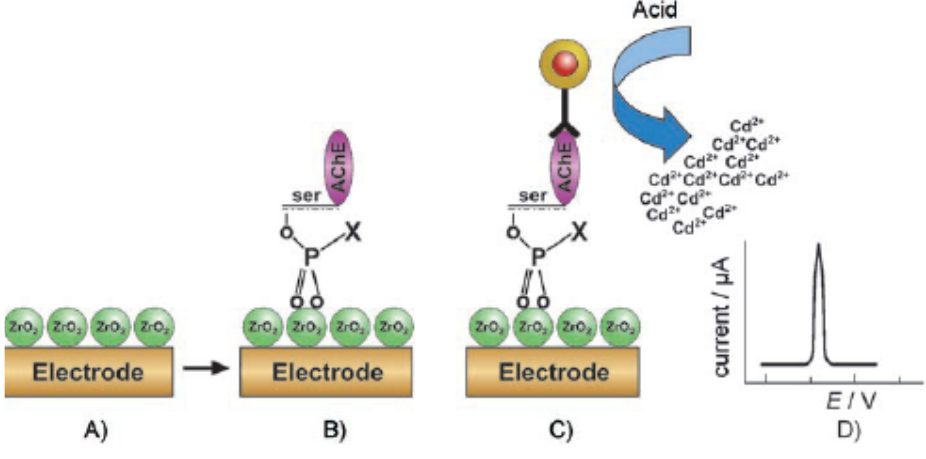
Figure 8. The principle of electrochemical immunosensing of phosphorylated AChE, (A) ZrO NPs modified SPE; (B) Selective capturing phosphorylated AChE adducts; (C) 2 Immunoreaction between bound phosphorylated AChE adducts and QD-labeled anti-AChE antibody; (D) dissolution of nanoparticles with acid following an electrochemical stripping analysis. (Reproduced with permission from Liu et al.